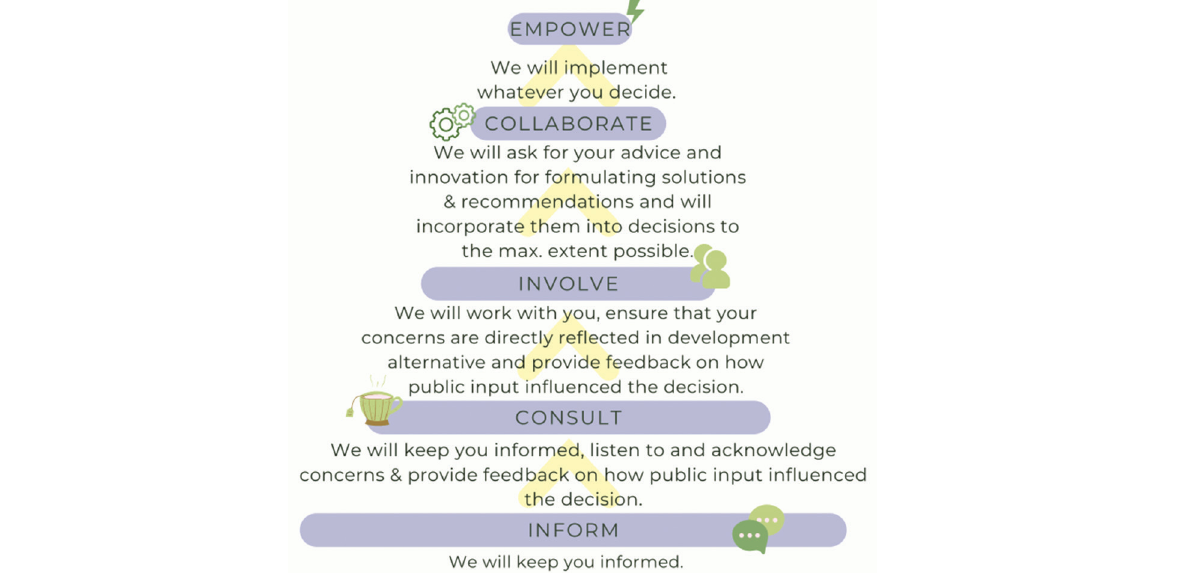
Figure 1. Levels of participation and aligned agreements (Source: Authors’ illustration, 2023, based on IAP2,